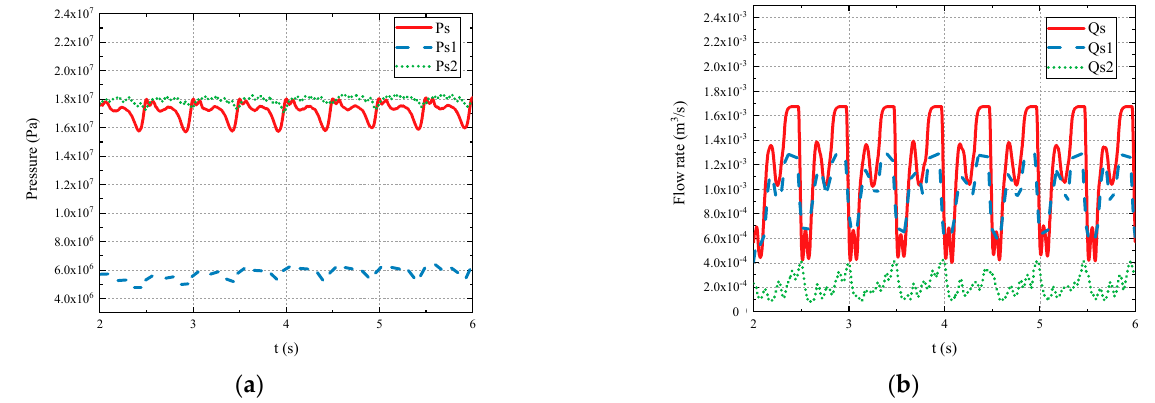
Figure 12. Pressure and flow rate of OSS and TSS: ( a ) Pressure of OSS and TSS; ( b ) Flow rate of OSS and TSS.